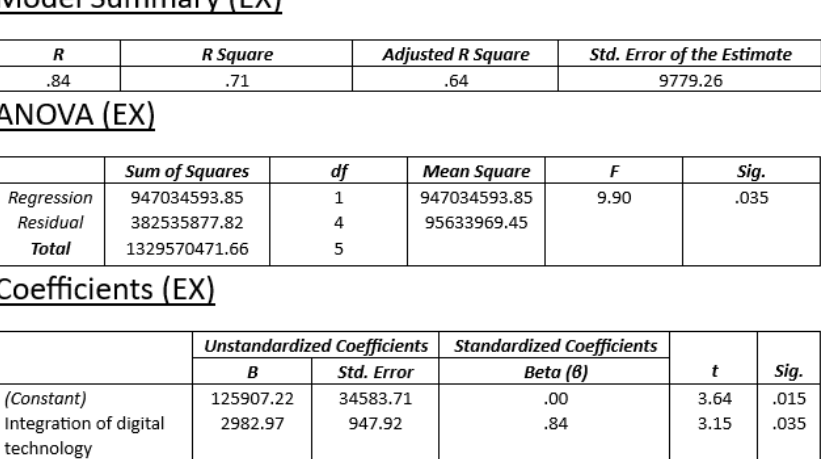
Figure 13. Linear regression: digitalization and gross value added—Romania.